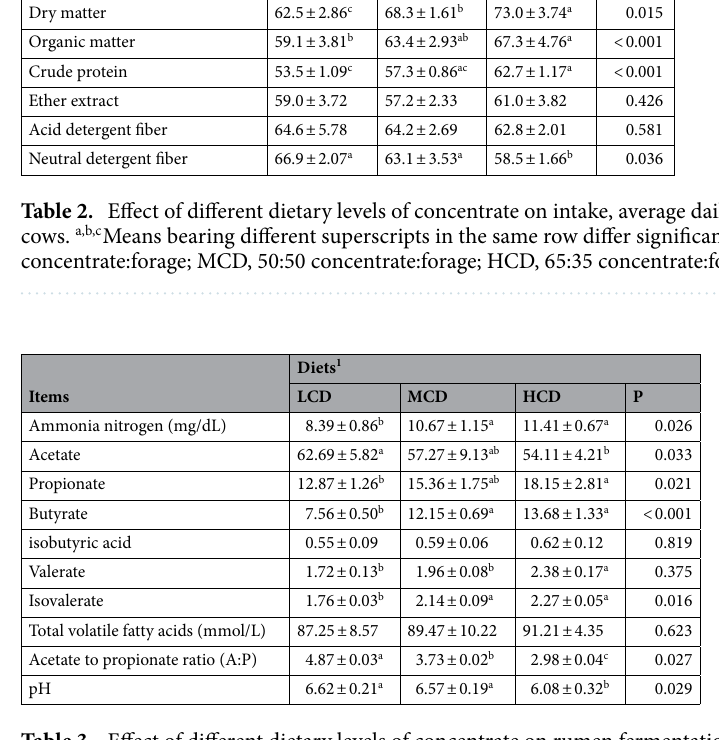
Table 3. Effect of different dietary levels of concentrate on rumen fermentation in Angus cows. a,b,c Means bearing different superscripts in the same row differ significantly ( P < 0.05). 1 LCD, 35:65 concentrate:forage; MCD, 50:50 concentrate:forage; HCD, 65:35